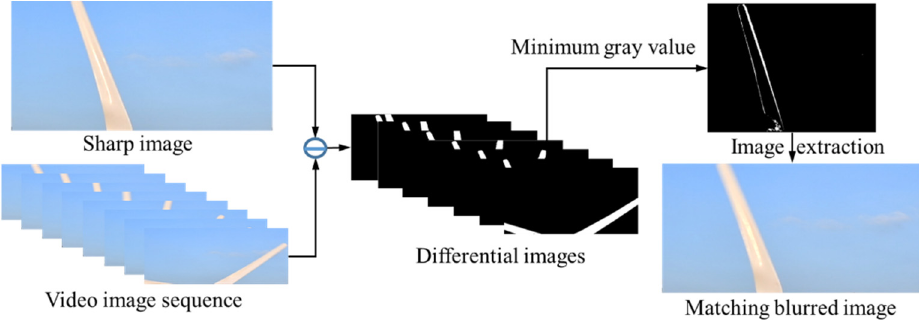
Figure 3. Image pair acquisition by image matching.